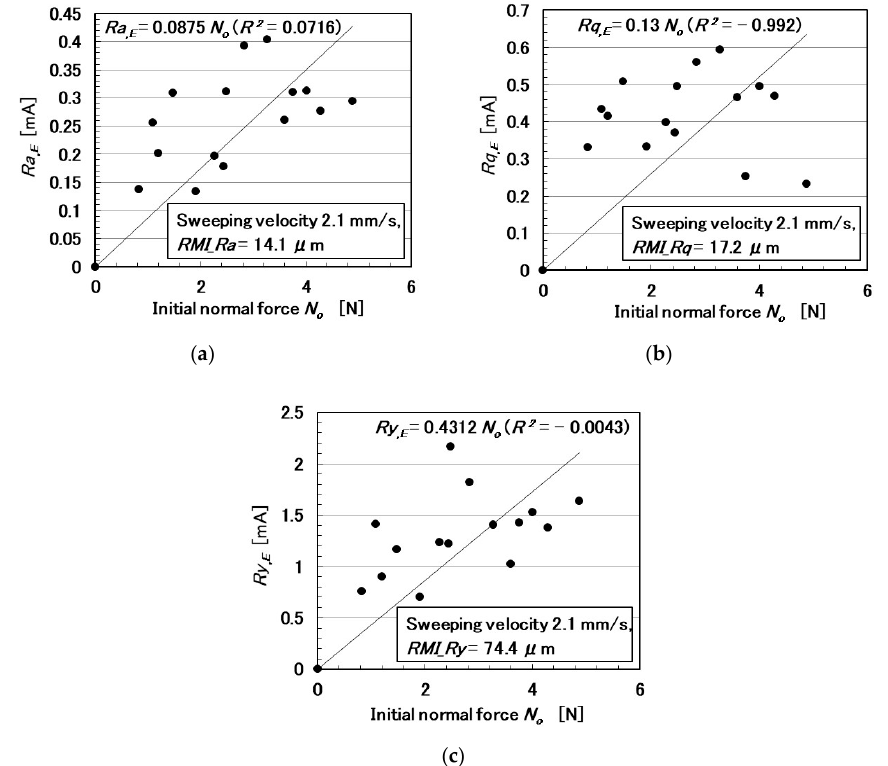
Figure 6. Relationship between electric current and initial normal force: ( a ) Ra .; ( b ) Rq .; and ( c ) Ry .